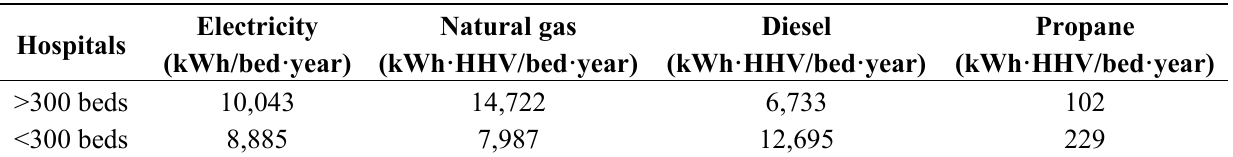
Table 1. Mean energy consumption per bed and year in Spanish